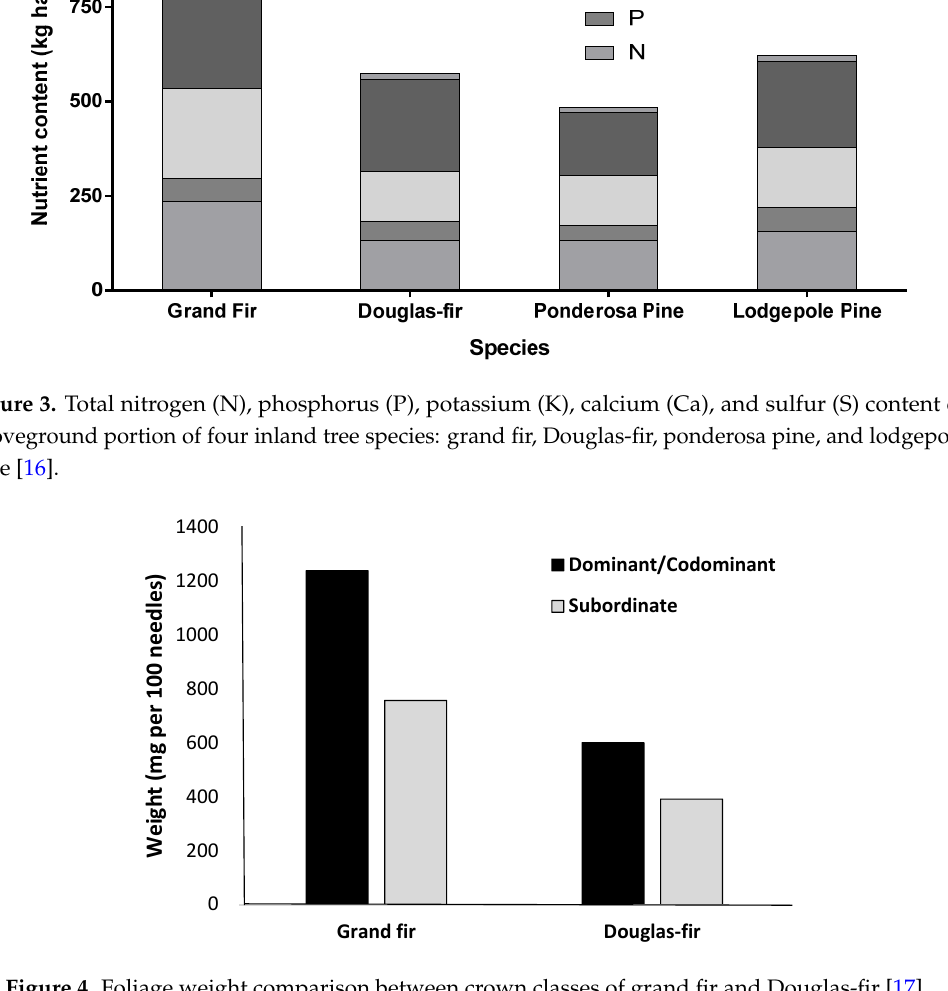
Figure 4. Foliage weight comparison between crown classes of grand fir and Douglas-fir [17].